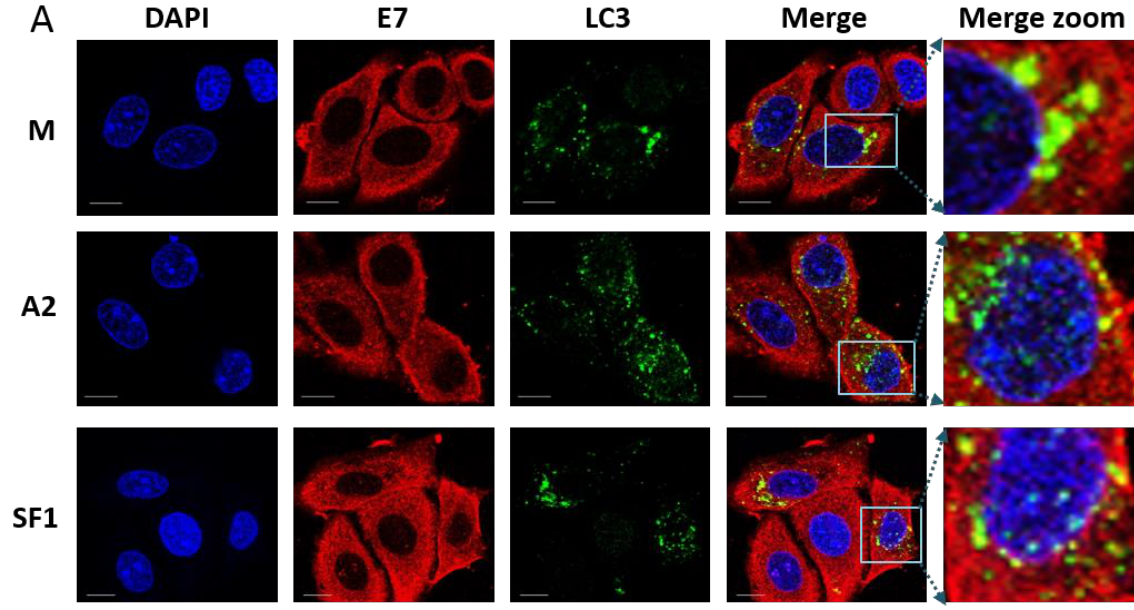
Figure 6. Cont Figure 6. Cont. Figure 6. Cont.